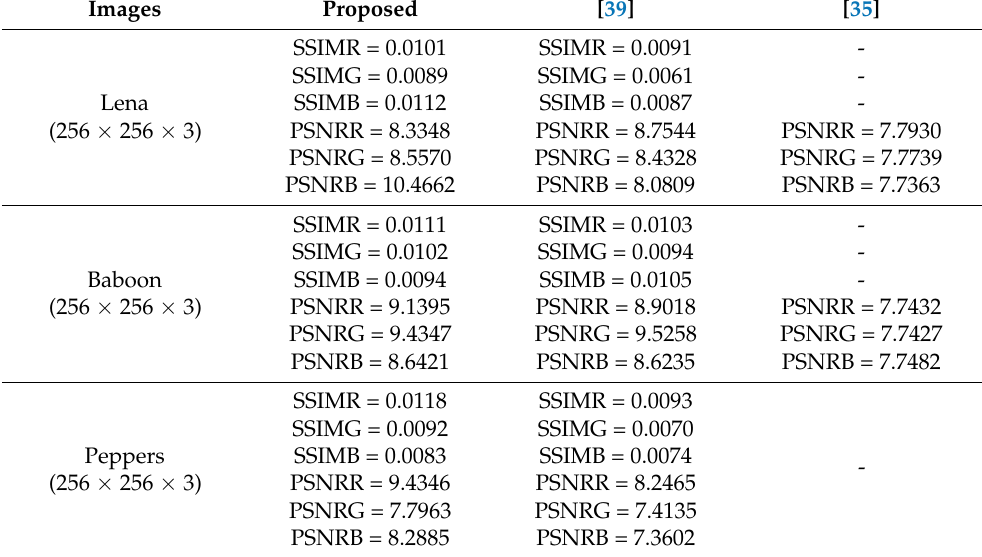
Table 7. SSIM and PSNR